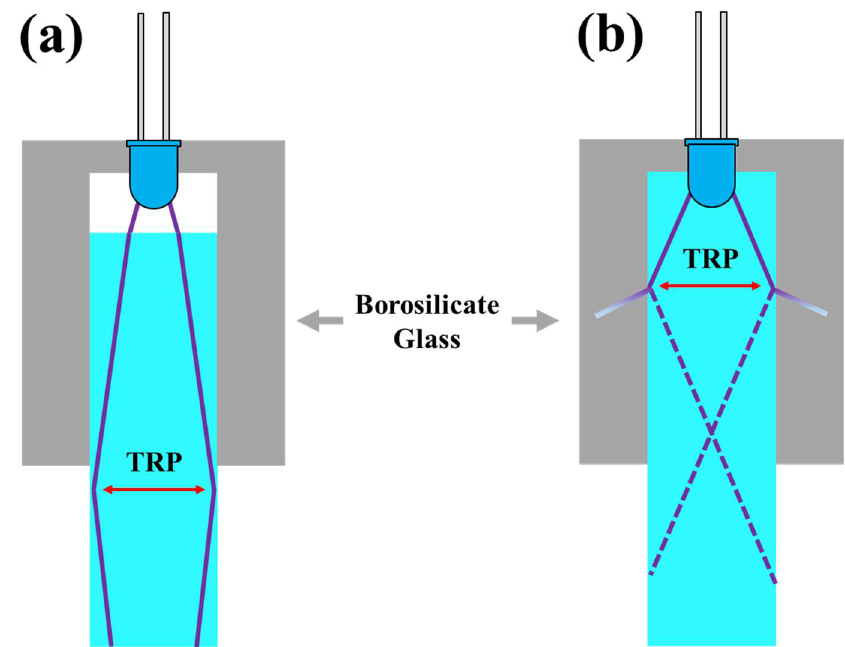
Figure 5. Change of the total reflection point (TRP) when the head of the LED-lens is ( a ) not immersed in water or ( b ) immersed in water. (a) When the lens is not immersed in water, the DUV emission with incident angle of 3° in air refracts to 2° in water. The first TRP point can be taken to a distant position (66 mm in our case), and there is no absorption material (borosilicate glass) at this position, thus the efficient total reflection occurs. (b) When the lens is immersed in water, the viewing angle of the DUV emission from the lens becomes wider (30 °) and the TRP moves closer to the DUV-LED (4.3 mm in our case). The 98% transmission of the DUV emission occurs from water to the borosilicate glass and in this case we cannot obtain the water-waveguide effect of the DUV light.